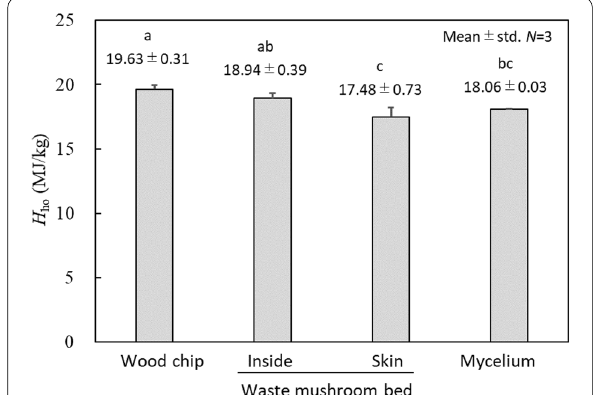
Fig. 5 Gross calorific values on a dry basis ( H ho ). Means with different letters are significantly different at P